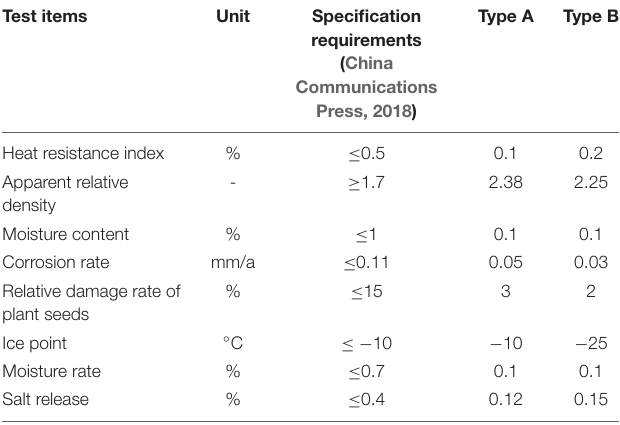
TABLE 3 | Basic properties of anti-icing fillers.